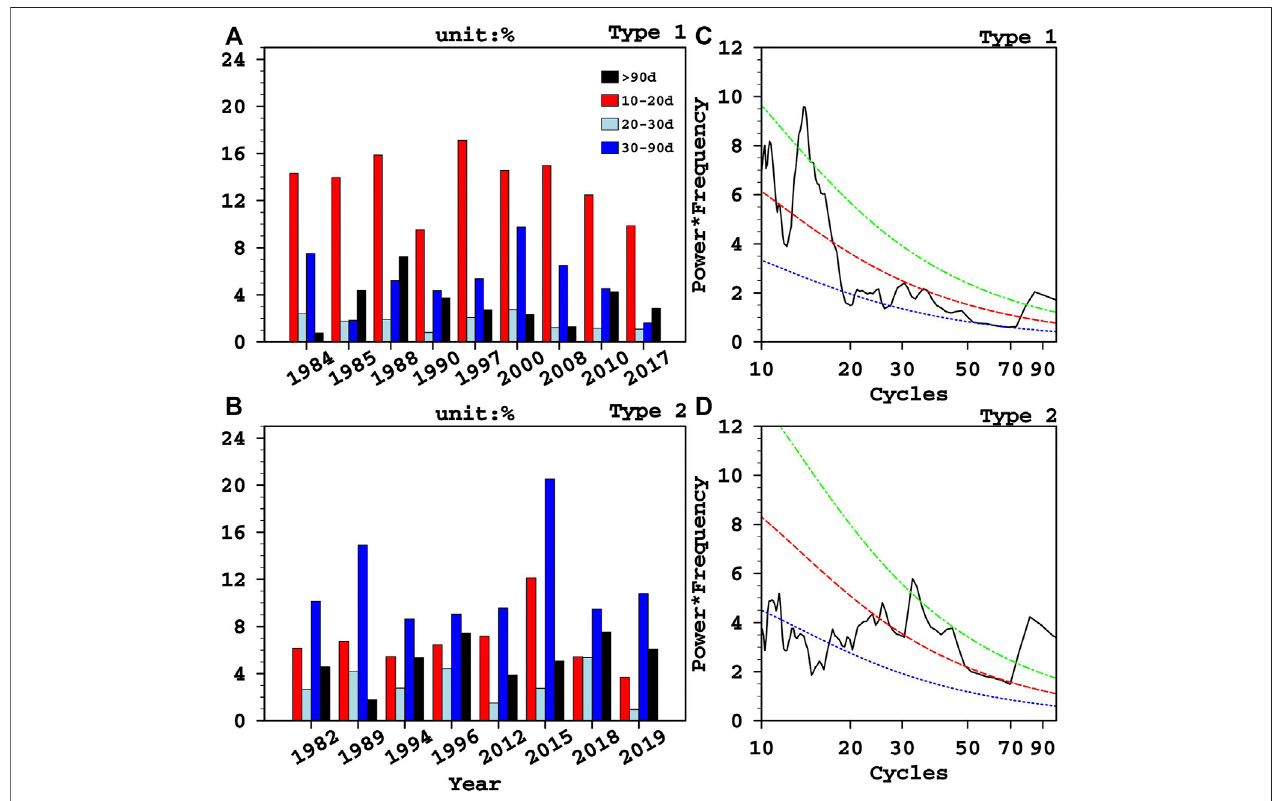
FIGURE3| Variancecontributionsofdifferentoscillations(10 – 20 days,20 – 30days,30 – 90 days,andequalandgreaterthan90 days)tosummerrainfallvariations of type 1 (A) and type 2 (B) years. Power spectrum analyses of regional averaged daily precipitation during summer of type 1 (C) and type 2 (D) years.